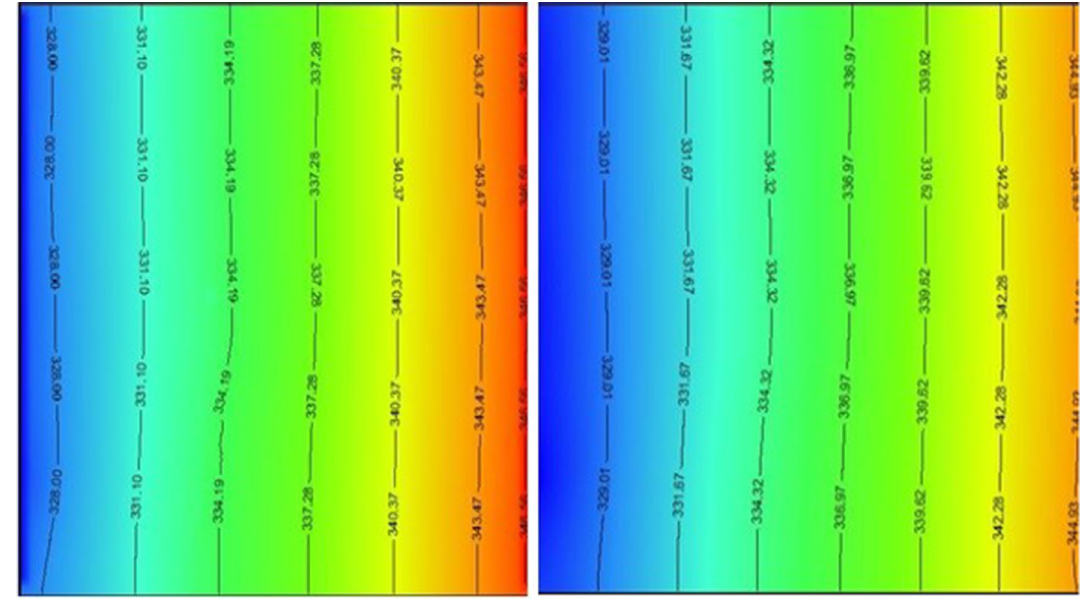
Fig. 8 Groundwater level head calibration of layers 1 and 2